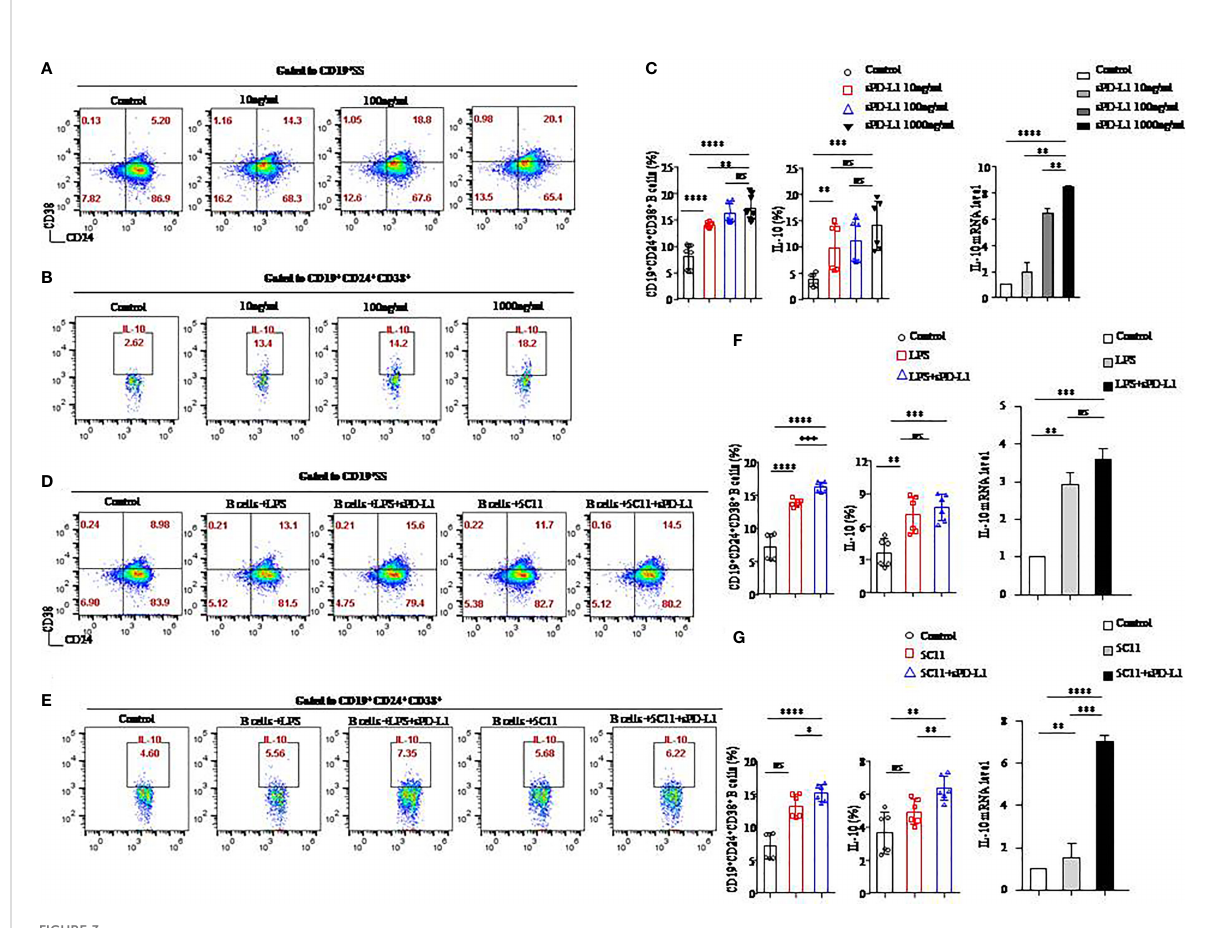
FIGURE 3 sPD-L1 mediated the differentiation of CD19 + B cells into CD19 + CD24 + CD38 + Bregs. CD19 + B cells enriched from the peripheral blood of healthy individuals were treated with sPD-L1 at doses from 10, 100, to 1,000 ng/ml. After 2 days, CD19 + B cells were collected and measured by fl ow cytometry. Representative fl ow cytometry dot plot of CD24 and CD38 expression in total CD19 + B cells (A) and IL-10 secreted by CD19 + CD38 + CD24 + B cells (B) . The proportion of CD19 + CD38 + CD24 + B cells (n = 6) and IL-10 secreted by CD19 + CD38 + CD24 + B cells (n = 6) was measured by fl ow cytometry (C) . The expression of IL-10 mRNA induced by sPD-L1 (C) . CD19 + B cells enriched from the peripheral blood of healthy individuals were activated with LPS, 5C11 (anti-CD40 Ab), or sPD-L1 individually or combinatorially, and fl ow cytometry dot plot of CD24 and CD38 expression in total CD19 + B cells (D) and IL-10 secreted by CD19 + CD38 + CD24 + B cells (E) . The proportion of CD19 + CD38 + CD24 + B cells (n = 6) and IL-10 secreted by CD19 + CD38 + CD24 + B cells (n = 6) was measured by fl ow cytometry, and the expression of IL-10 mRNA induced by LPS or sPD-L1 individually or combinatorially was measured (F) . The proportion of CD19 + CD38 + CD24 + B cells (n = 6) and IL-10 secreted by CD19 + CD38 + CD24 + B cells (n = 6) were measured by fl ow cytometry, and the expression of IL-10 mRNA was induced by 5C11 or sPD-L1 individually or combinatorially (G) . Data represent the means ± SEM of at least three independent experiments and were analyzed by Student ’ s t test. ns, not statistically signi fi cant. * P < 0.05, ** P < 0.01, *** P < 0.001, and **** P <